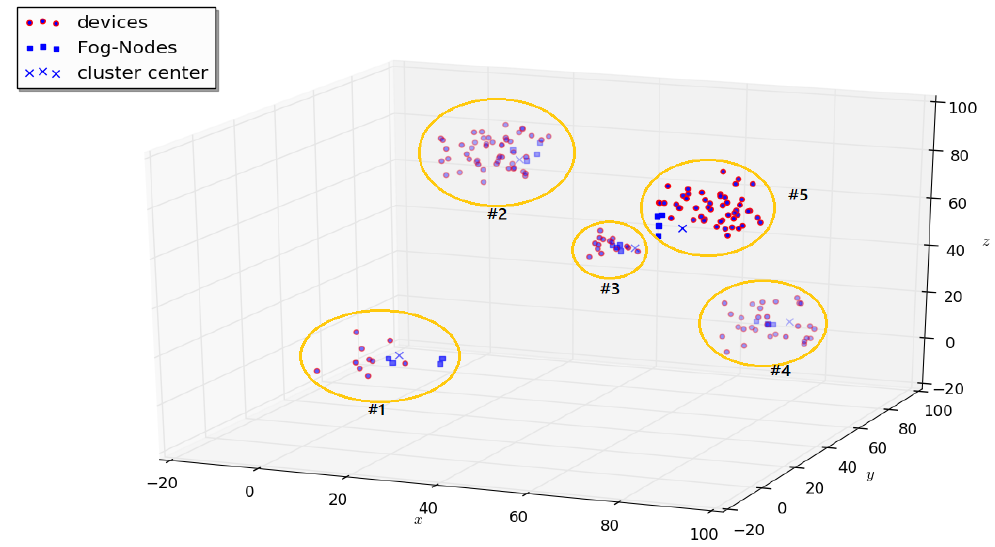
Figure 8. Generated